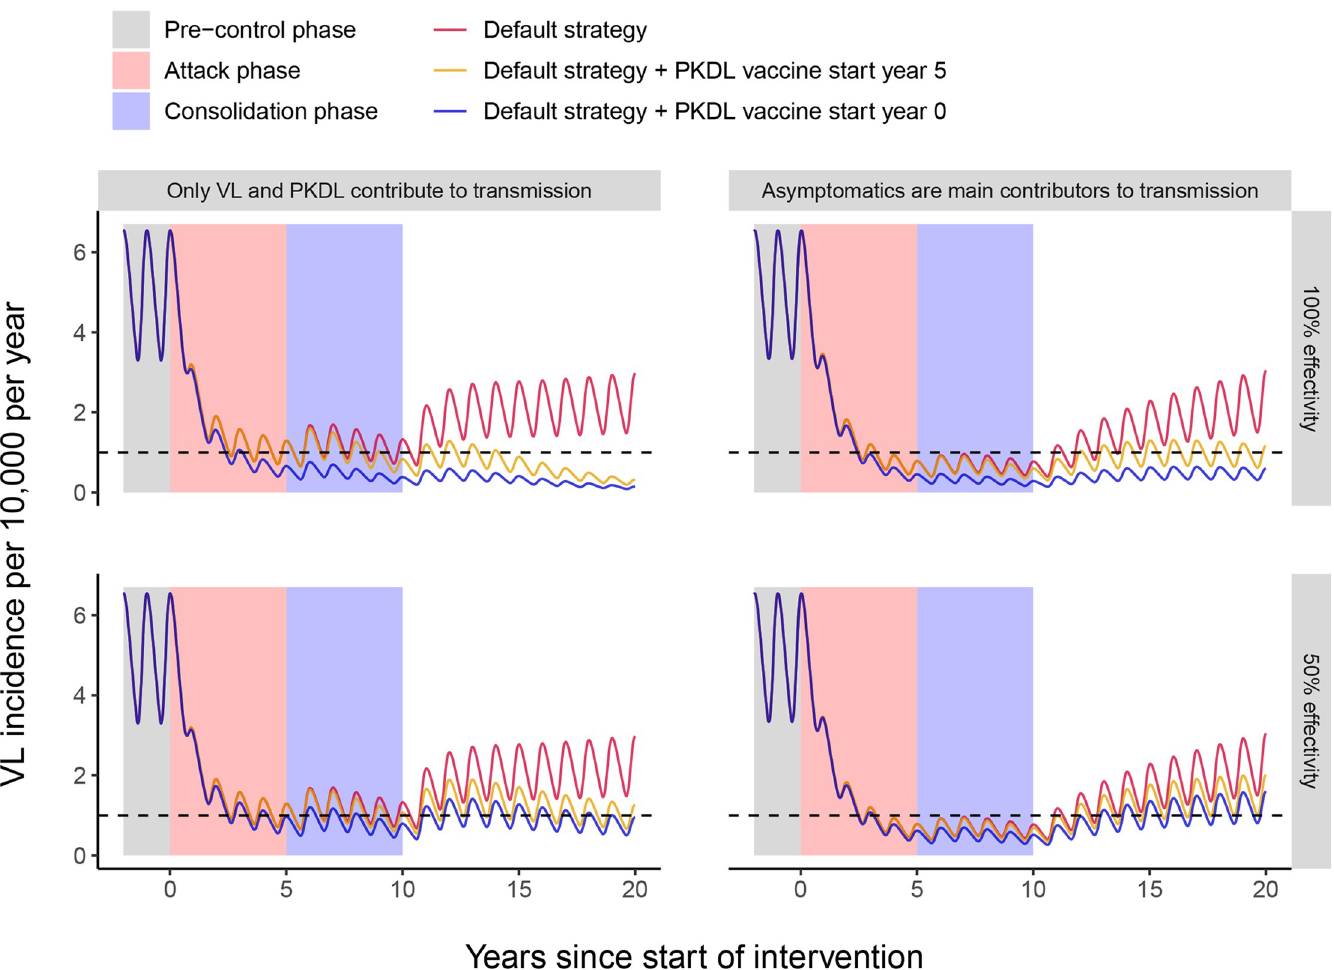
Fig 3. Strategies of combining vaccine effect 3 with the WHO attack and consolidation phase for a setting with a pre-control endemicity level of 5/10,000/year. Top panels: vaccine effect with 100% protection against the development of PKDL, bottom panels: vaccine effect with 50% protection against the development of PKDL. The default strategy is visualized with the red line (top and bottom row identical), in which 5 years of attack phase are followed by 5 years of consolidation phase, after which interventions are halted in year 10. For the green line, the PKDL vaccine is introduced during the consolidation phase (year 5), which continues after the consolidation phase has ended at year 10. For the blue line, the PKDL vaccine is already introduced at the start of the attack phase (year 0), continues during the consolidation phase and is continued when regular interventions are halted in year 10. Left figures show the simulations for the model variant where solely symptomatic individuals contribute to transmission, whereas for the right figures asymptomatic individuals constitute the main reservoir of infection. The black dashed line represents the WHO VL incidence target of 1/10,000/year. The oscillations in VL incidence are a result of seasonality in the sand fly